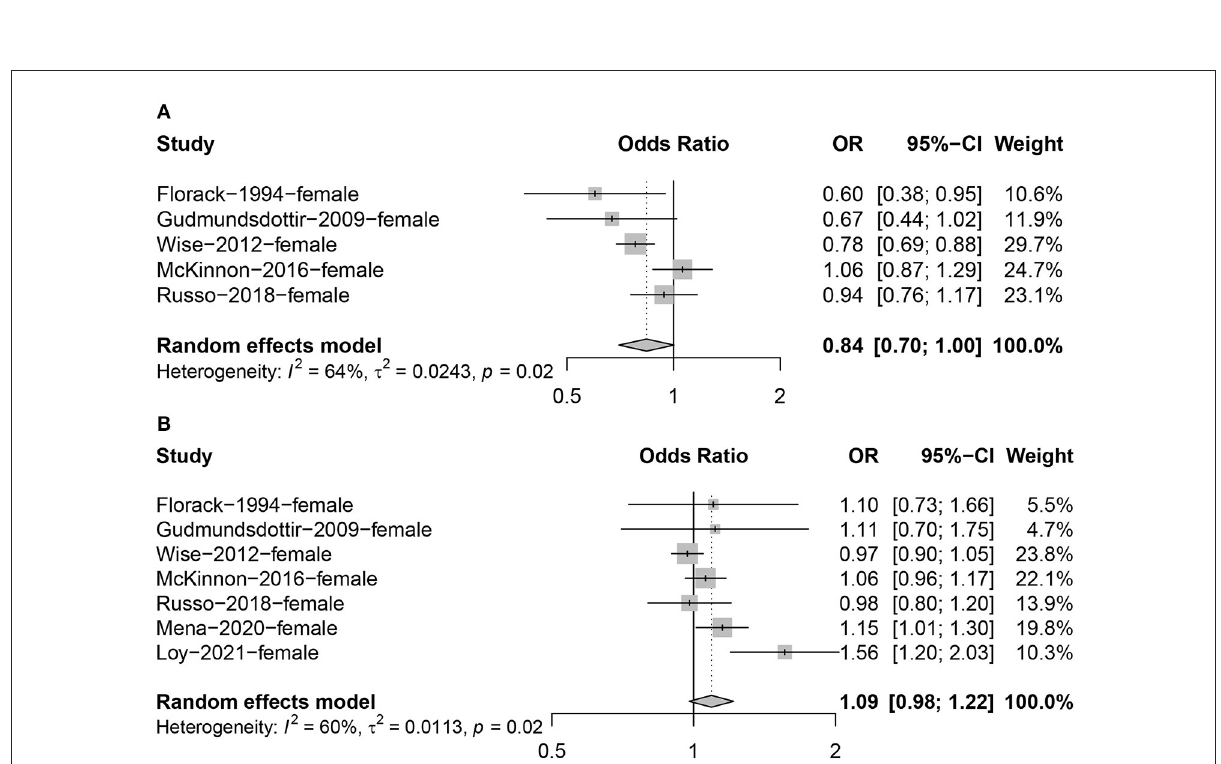
FIGURE3 Forest plot of the combined effect size of the effects of high (A) and moderate (B) intensity physical activity on fertility compared to the lowest levels of physical